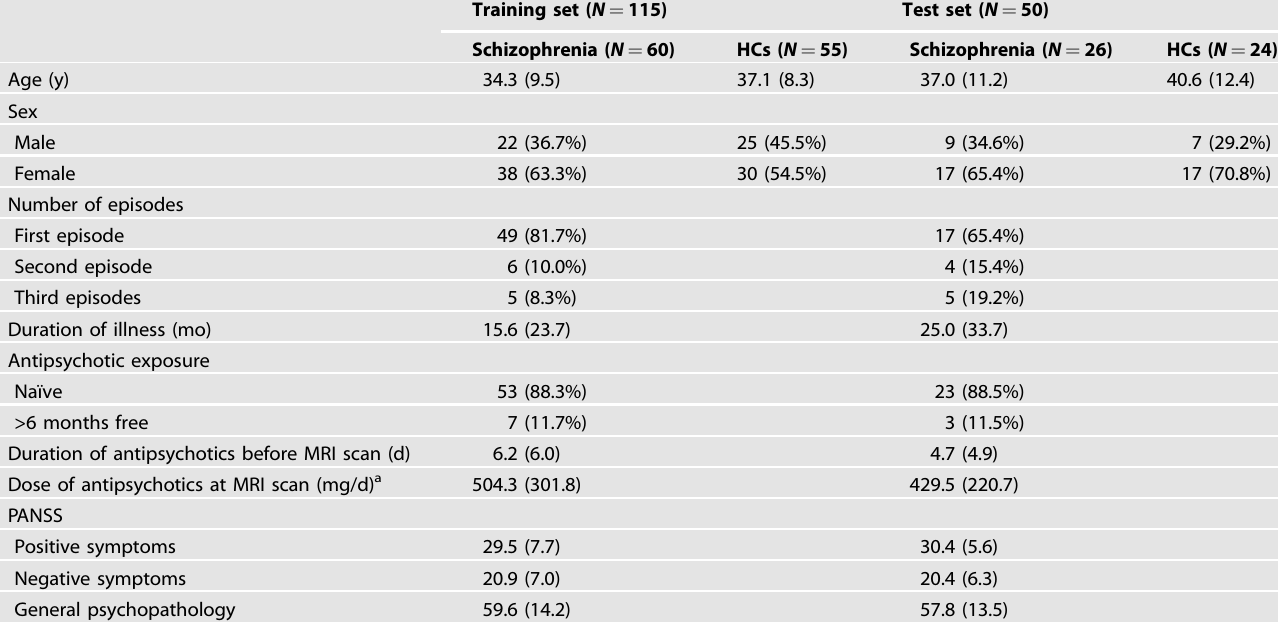
Table 1. Demographic and clinical pro fi les of the study participants in the training and test